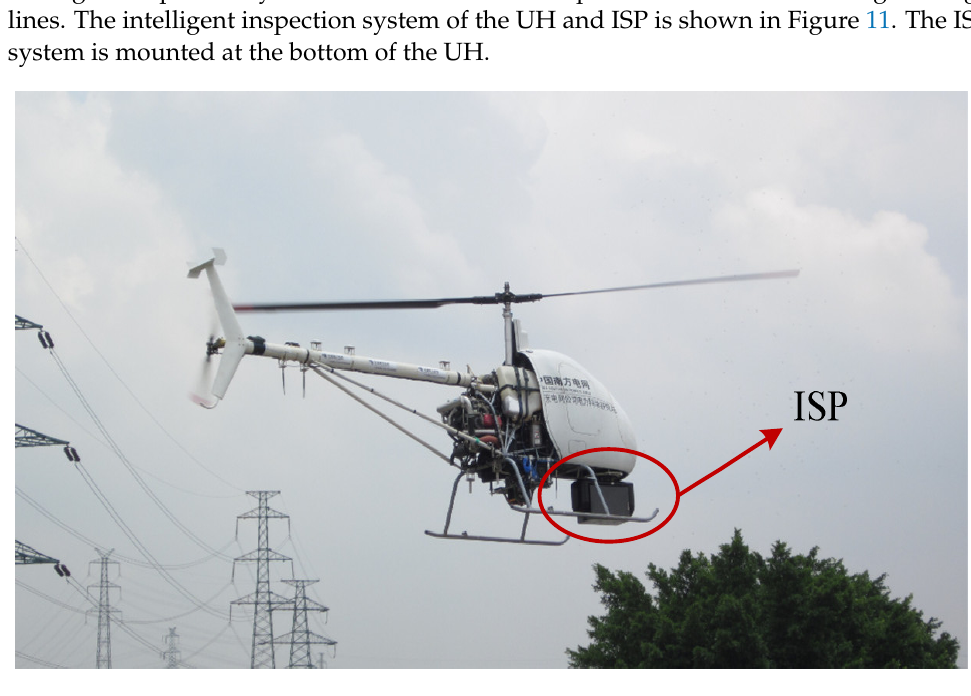
Figure 11. The intelligent inspection system.